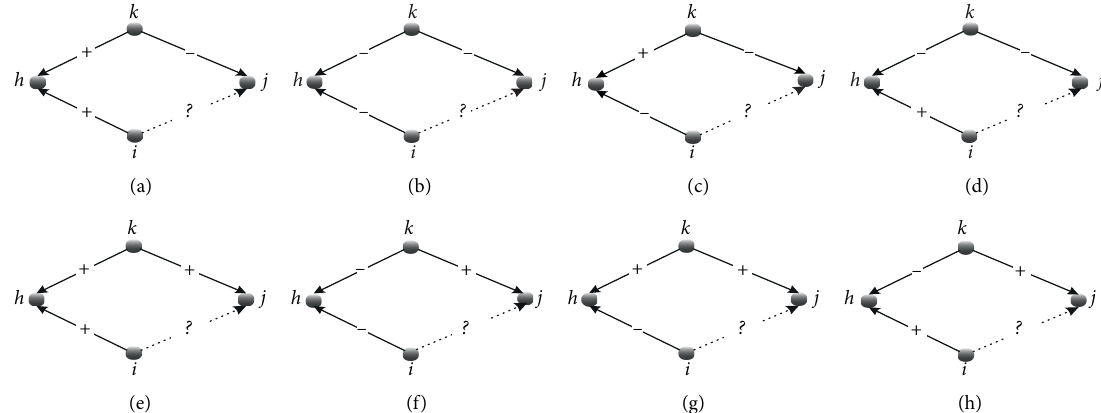
Figure 2: Positive and negative similarity. Panels (a)–(d) denote positive similarity, whereas panels (e)–(h) denote negative